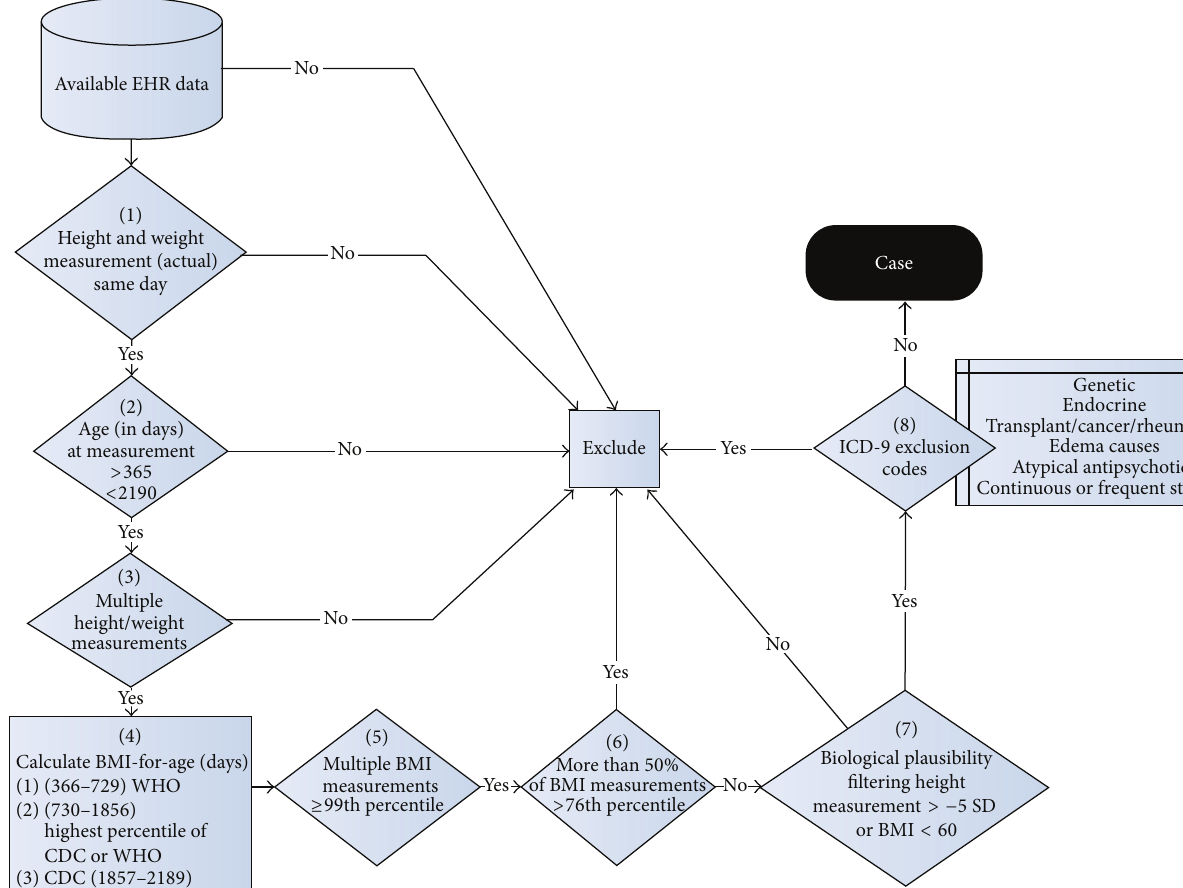
Figure 1: Severe early childhood obesity electronic algorithm. EHR data: available electronic medical record data. Patients required both a height and weight recorded on the same day with height or length > − 5 SD for age and gender, at least 2 BMIs ≥ 99th percentile, and > 50% of all BMIs > 76th